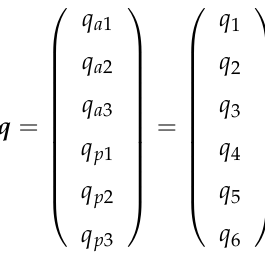
Figure 5. The sketch representing the body frames of the virtual isolated bodies. The quasi-coordinates q ∈ (cid:60) 6 × 1 are represented